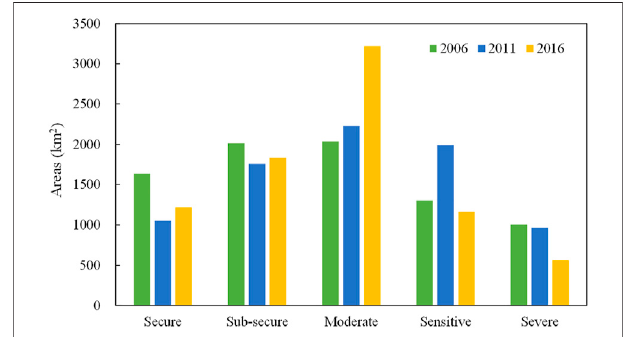
FIGURE 3 | Areas of land ecological security levels in Jinan from 2006 to